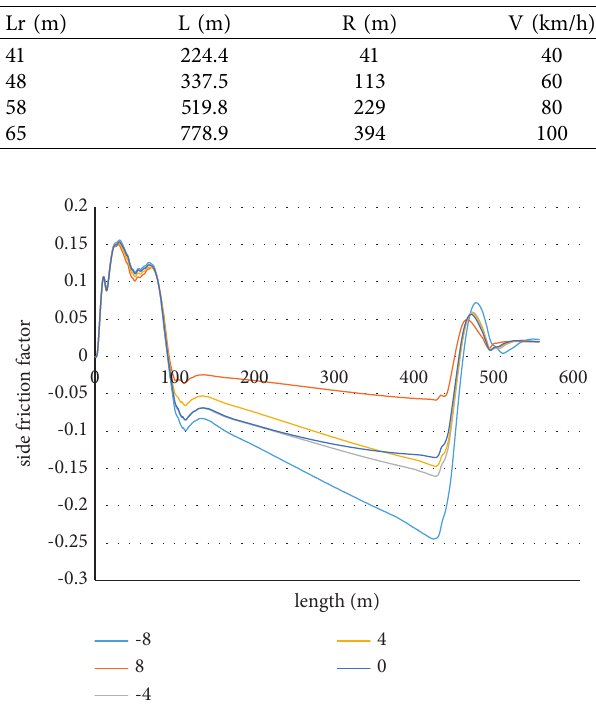
Table 2: Path characteristics in the desired tests.